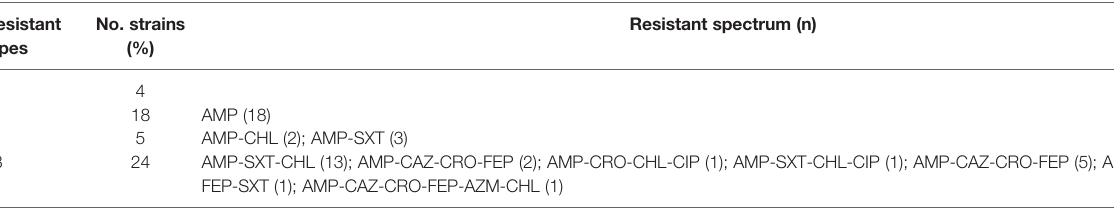
TABLE 2 | Distribution of NTS strains resistant to antibiotics and resistant spectrum. Resistant No. strains types